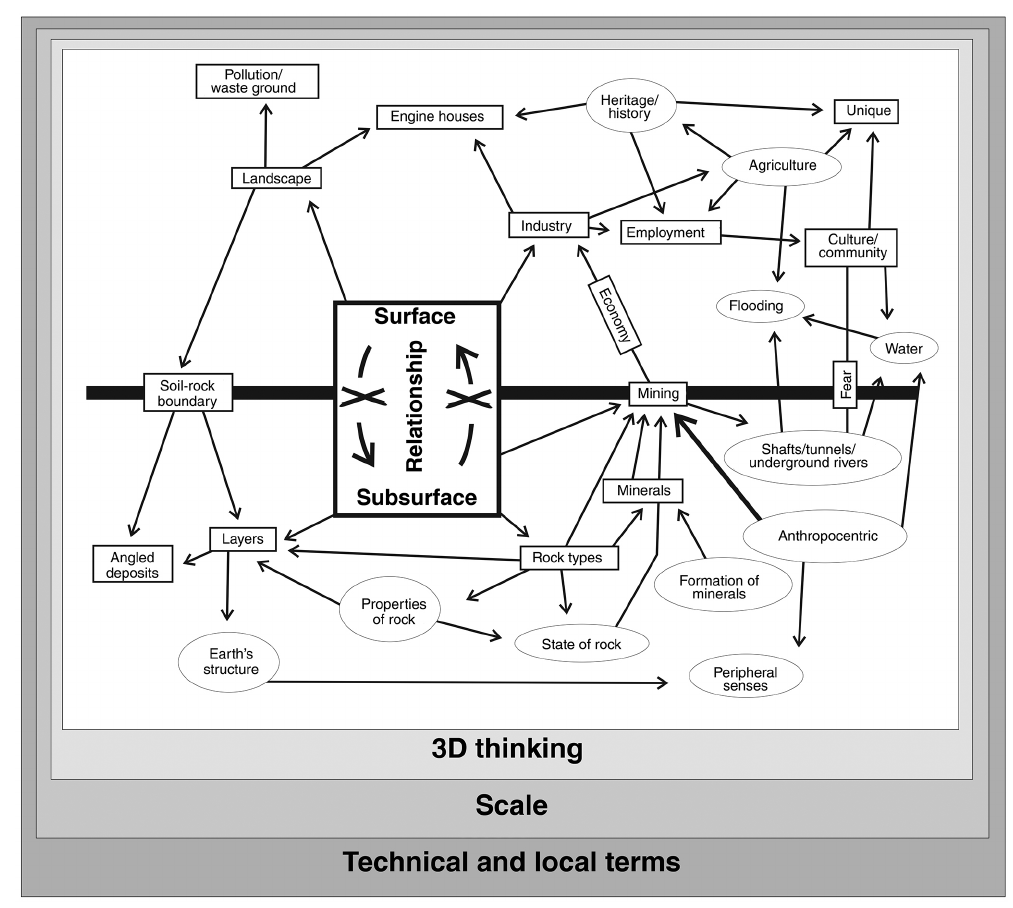
Figure 5. A mental model of expert and non-expert perceptions of the subsurface in the south-west of England. Rectangular nodes are those shared between experts and non-experts; oval nodes are those expressed by non-experts alone. The three frames “3-D thinking”, “scale” and “technical and local terms” have been placed externally as they provide context for all of the other